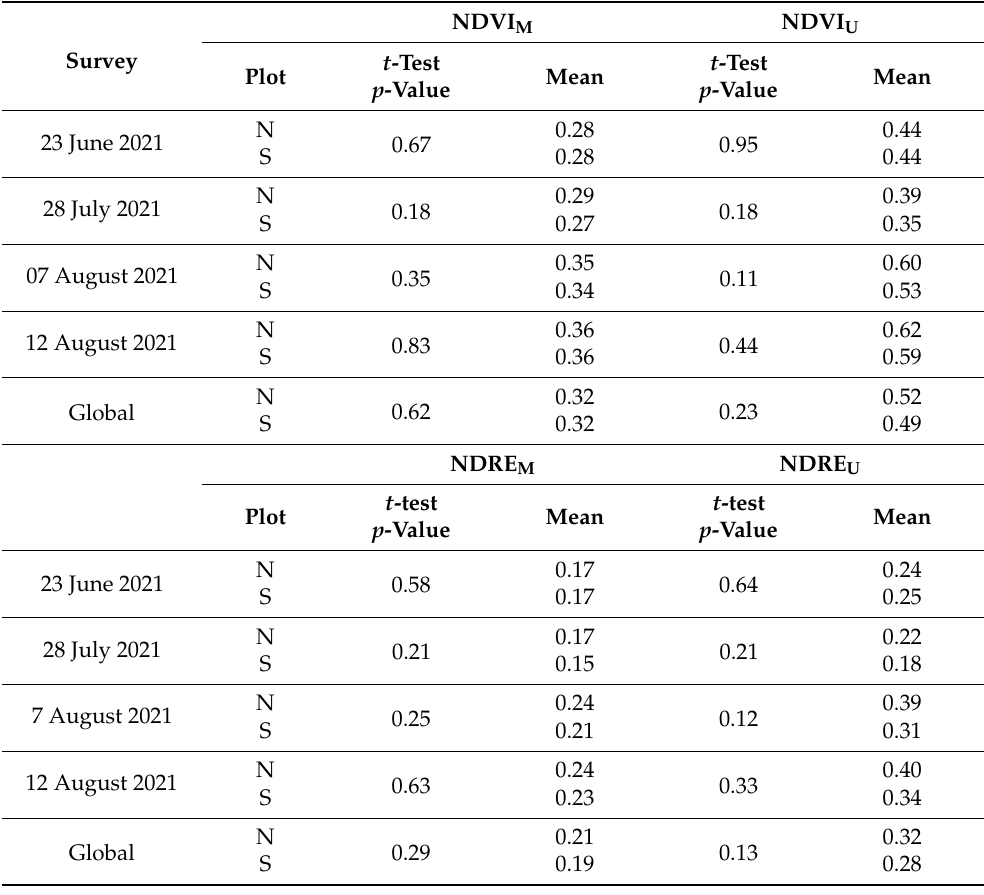
Table 5. VI M , VI U , NDWI M and NDWI U statistics of plots N and S over single and aggregated surveys (significance p <